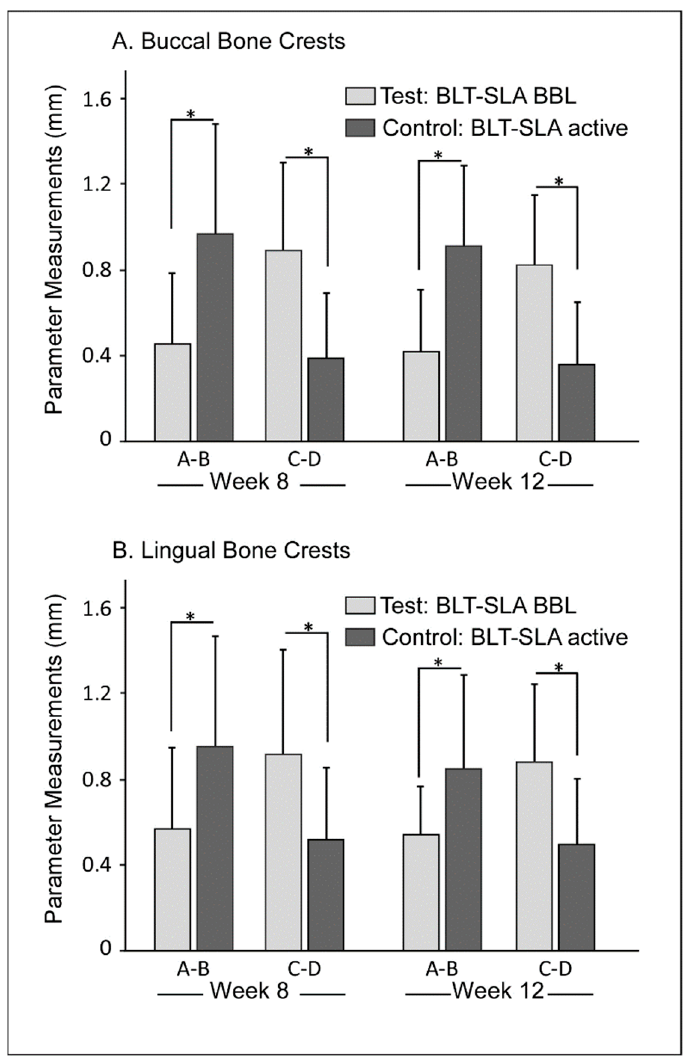
Figure 6. Crestal bone loss and tissue thickness (mm) at 8 and 12 weeks post-implantation. Buccal and lingual bone crests within each parameter ( A – D ) represent slightly statistically significant dif- ferences for pairwise comparisons (* p <